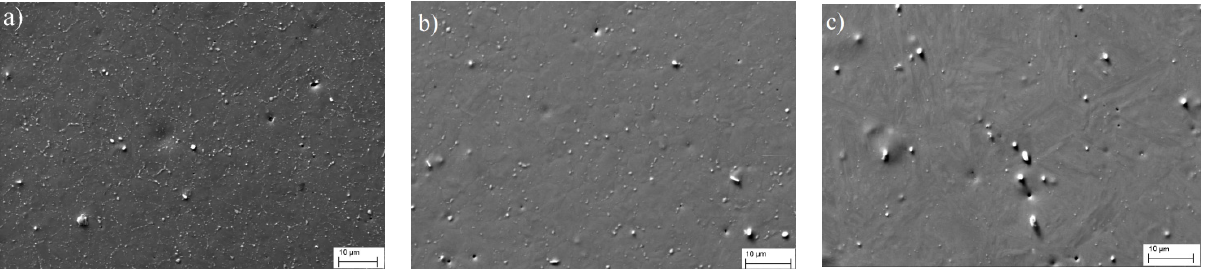
Figure 7. The influence of heating temperature on the distribution of carbide phases in the structure of ChS-139 steel (SEM): heating temperature of ( a ) 885 °C; ( b ) − 900 °C; ( c ) − 1200 °C.